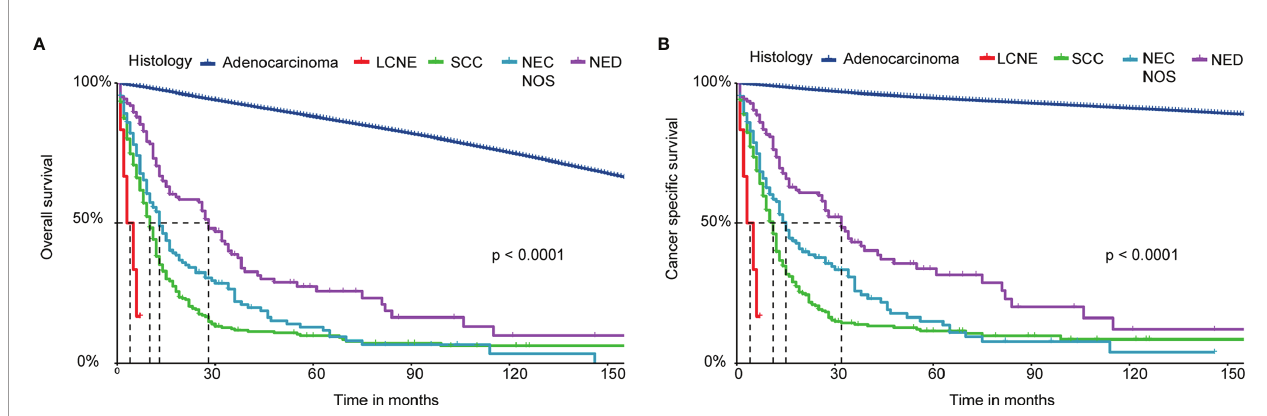
FIGURE 2 | Survival analysis of OS and CSS for patients with four histological subtypes of NEPC and prostate adenocarcinoma. (A) Kaplan-Meier analysis of OS; (B) Kaplan-Meier analysis of CSS. NEPC, neuroendocrine prostate cancer; LCNE, large cell neuroendocrine carcinoma; SCC, small cell carcinoma; NEC NOS,